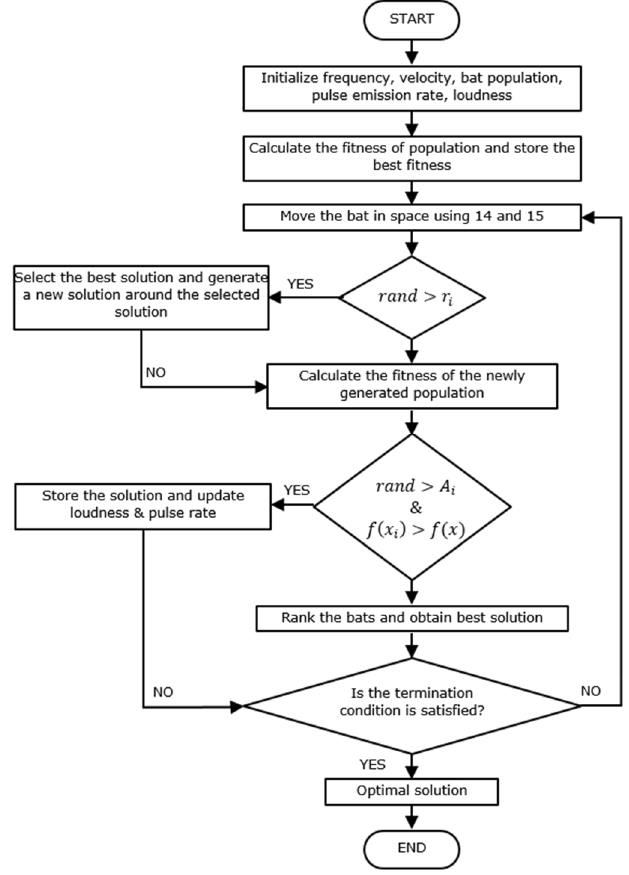
Figure 2. Bat Algorithm Flowchart.